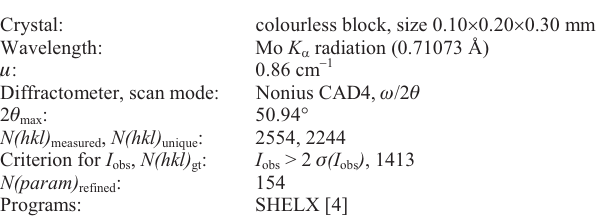
Table 1. Data collection and handling.